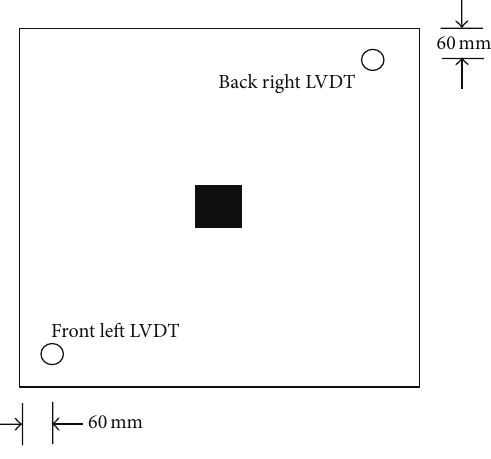
Figure 10: LVDT’s locations on the top of all slabs.